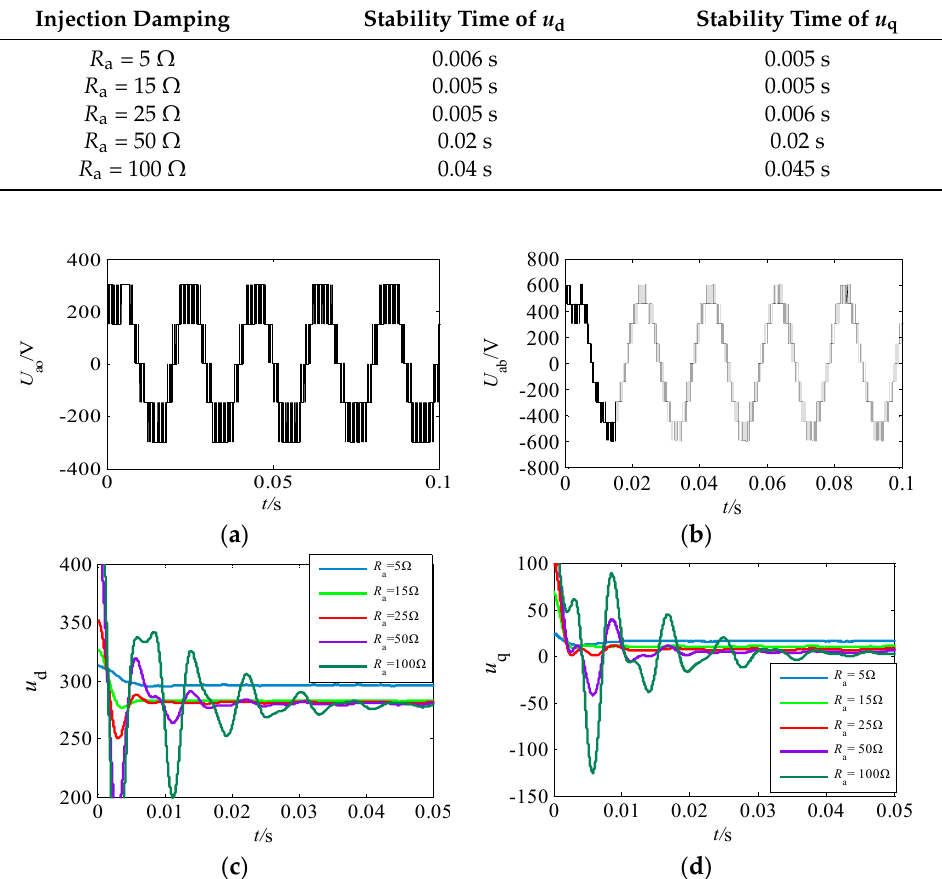
Table 2. Stability time of u d and u q .